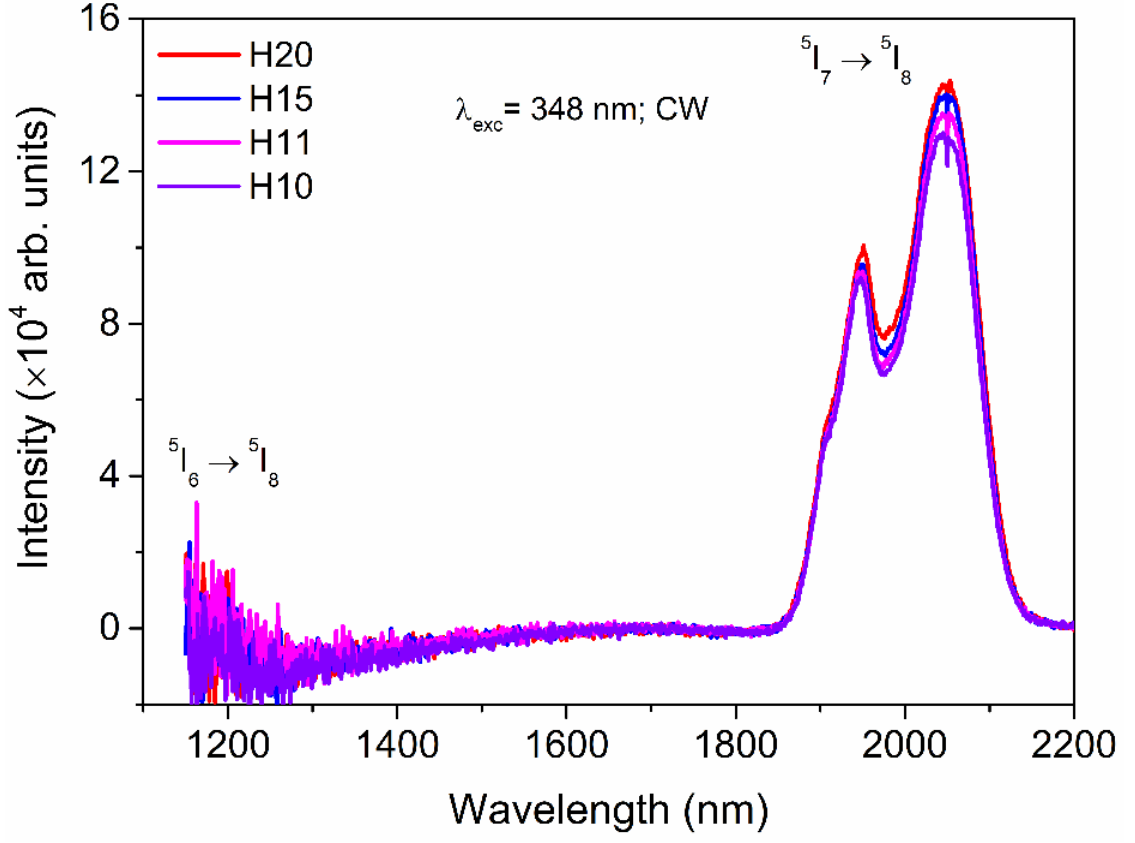
Figure 9. Downshifting spectra in the infrared range of Ho-SiAlON samples under 348 nm CW